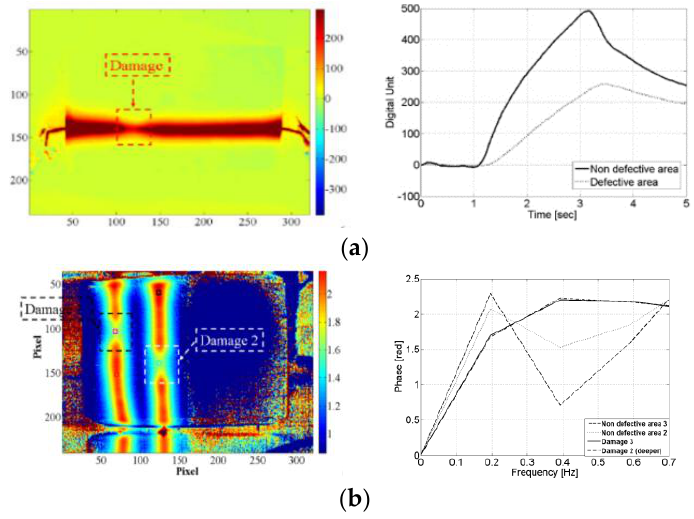
Figure 24. SMArt multifunctional laminate: time history of the temperature difference variation between damaged and undamaged part (4 plies CFRP in cross-ply stacking sequence, single damage) ( a ); phase profile of two different damage sites (16 plies, cross-ply stacking sequence, multi-damage) ( b ), with permission from 34.